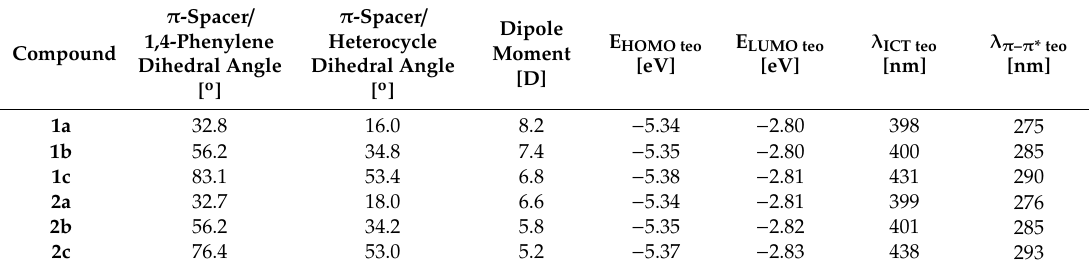
Table 1. Predicted molecular and electronic properties of the studied